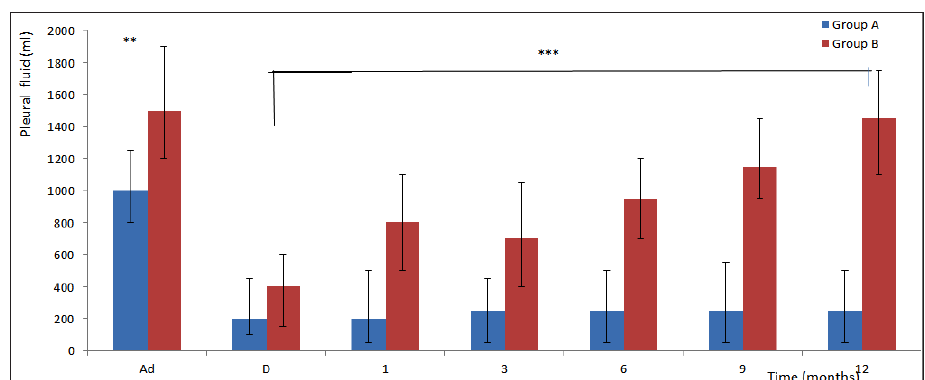
Fig. 2. Evolution of the values for sCD-163 in groups A and B. *** P <0.001, * P <0.05